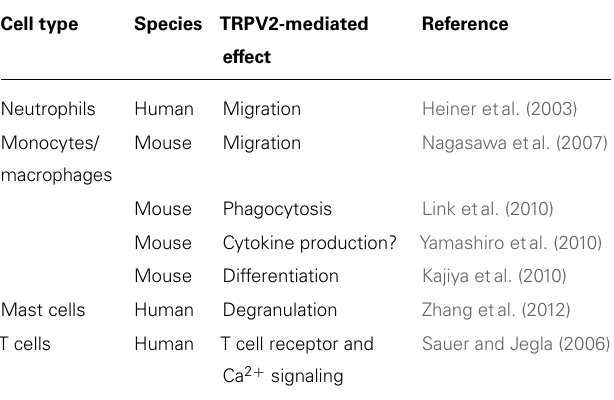
Table 1 | Role ofTRPV2 in immune